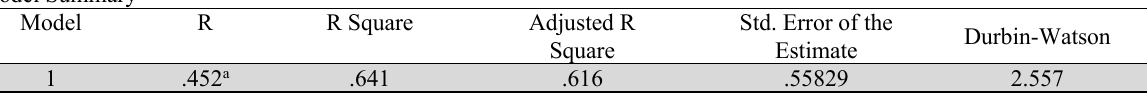
Model Summary b Model R R Square Adjusted R